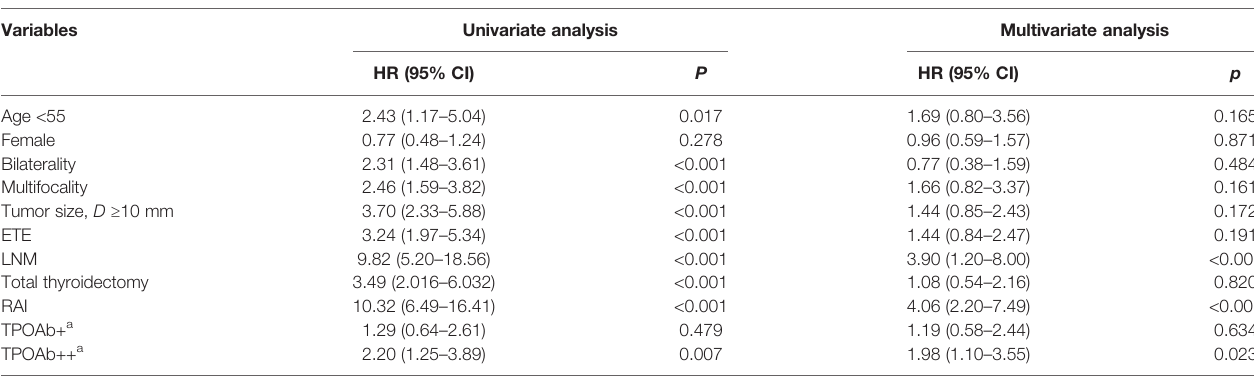
TABLE 3 | Association between recurrence and TPOAb levels of PTC patients.